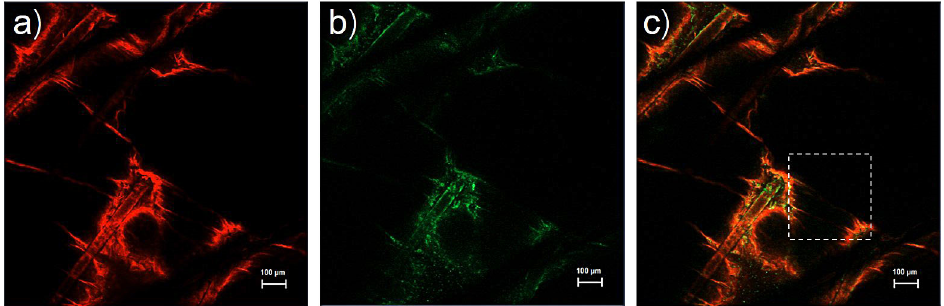
Figure 3. Top view images (x-y plane) of the skin treated with rhodamine B base-loaded NBD-PE- labeled ultradeformable liposomes at 30 min; ( a ) red fluorescence of rhodamine B base, ( b ) green fluorescence of NBD-PE, and ( c ) merged image of ( a , b ). The scale bar represents 100 µ m. The serial x-z plane images of the marked area in Figure 3c are shown in Figure 4a.